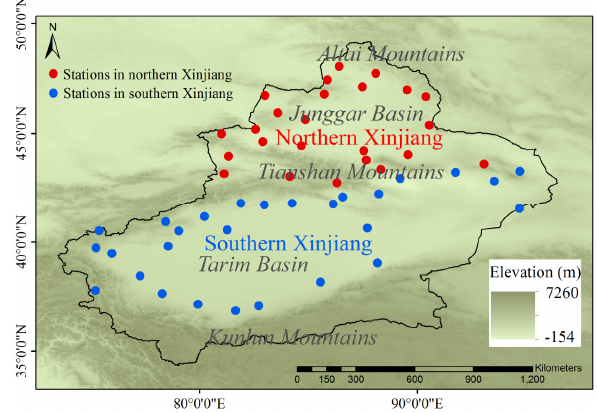
Figure 1. The geographical distribution of the 52 weather stations in Xinjiang, as well as the sub-regions (northern and southern Xinjiang).